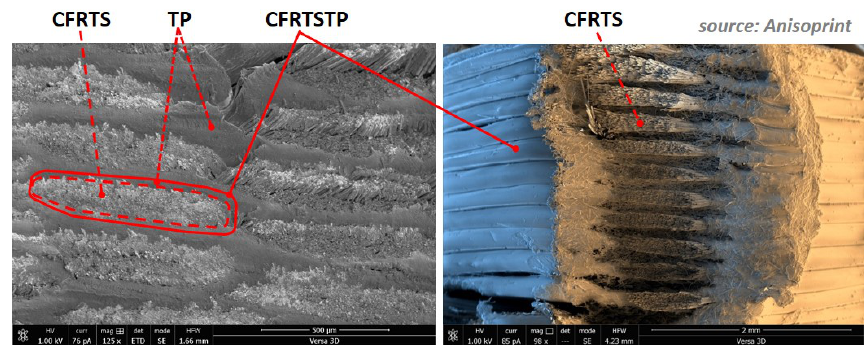
Figure 3. Three-dimensionally printed CFRP composite material based on the bi-matrix thermoset (TS)-thermoplastic (TP) FFF technology.